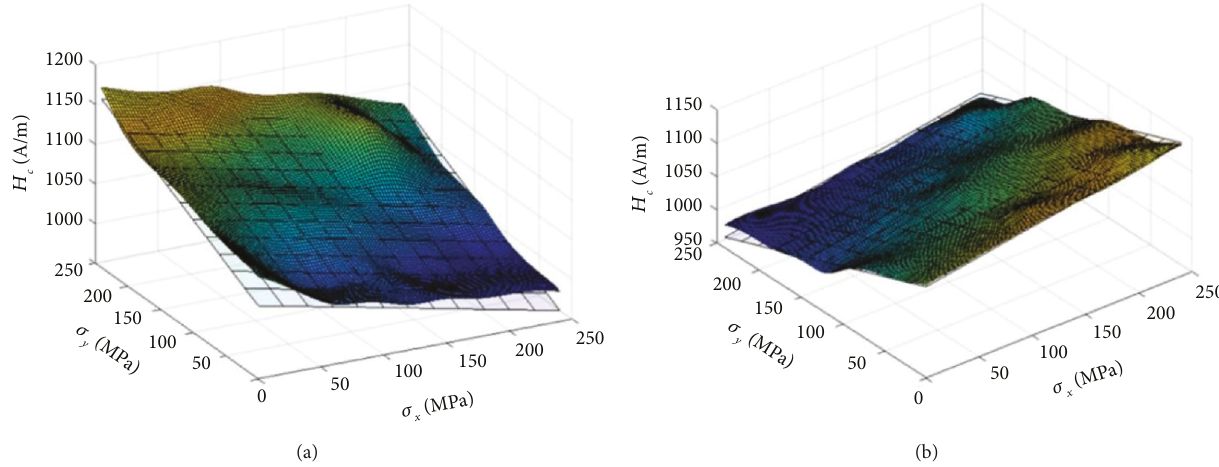
Figure 18: Binary one-time fitting of test piece experimental data. (a) Coercive force fitting of test piece 2 in X direction � − 0 . 4944 σ + 0 . 3291 σ + 1043. (b) Coercive force fitting of test piece 2 in Y direction Hc Hc x x y